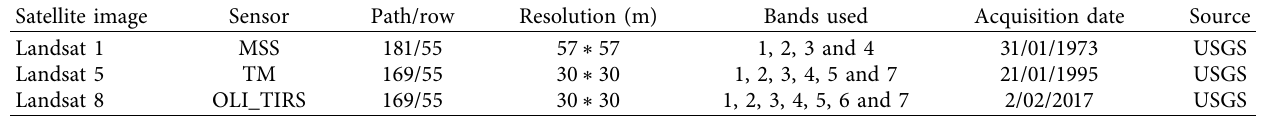
Table 1: Characteristics of images used for land use/land cover change analysis.